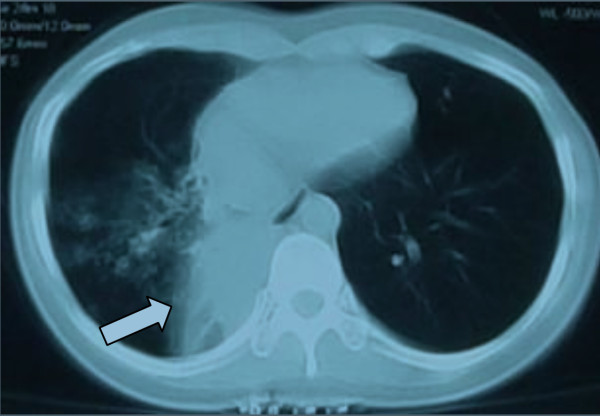
Computed tomography scan of the chest showed partial atelectasis of the right lower lobe (arrow) before treatment. (13 October 2011).